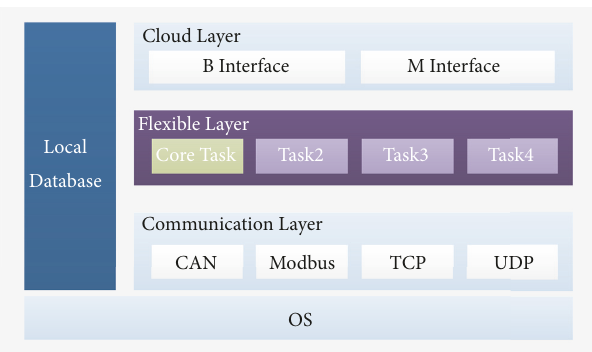
Figure 2: The software architectureof ePLC whichencompasses the cloud layer, the flexible layer, and the communication layer all based on the operating system (OS). There is also a local database.